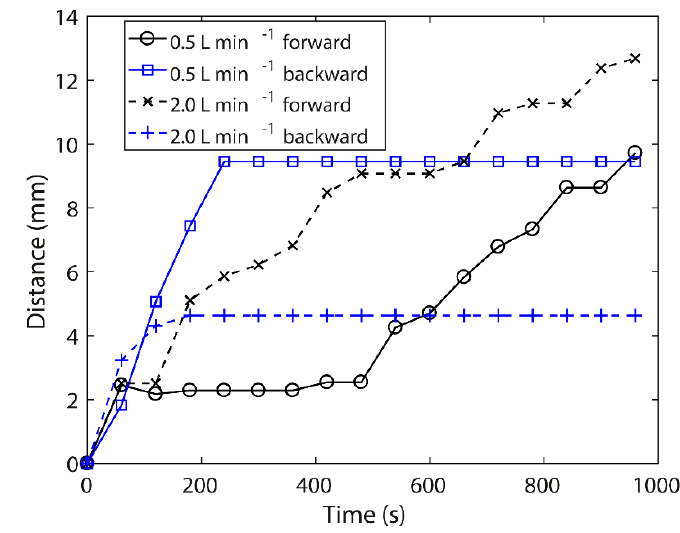
Figure 7. Liquid water penetration length for foam B.